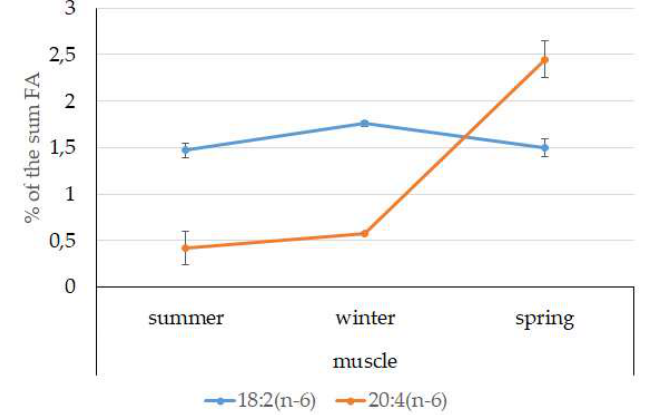
Figure 9. Seasonal dynamic of certain (n-6)PUFA levels (% of the sum of FAs) in muscle in postlarval (L3 developmental stage) daubed shanny from Kongsfjord. The data presented as M ± SE.